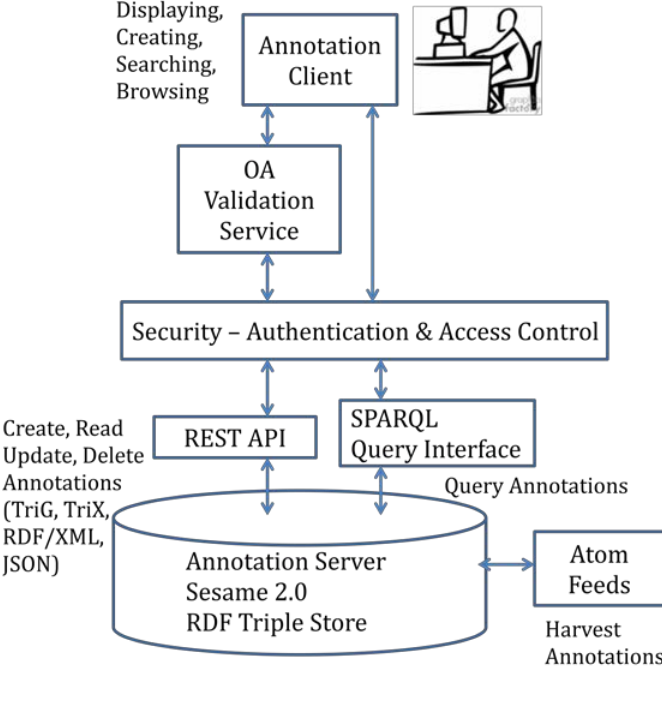
Figure 9. Technical components of the lorestore annotation